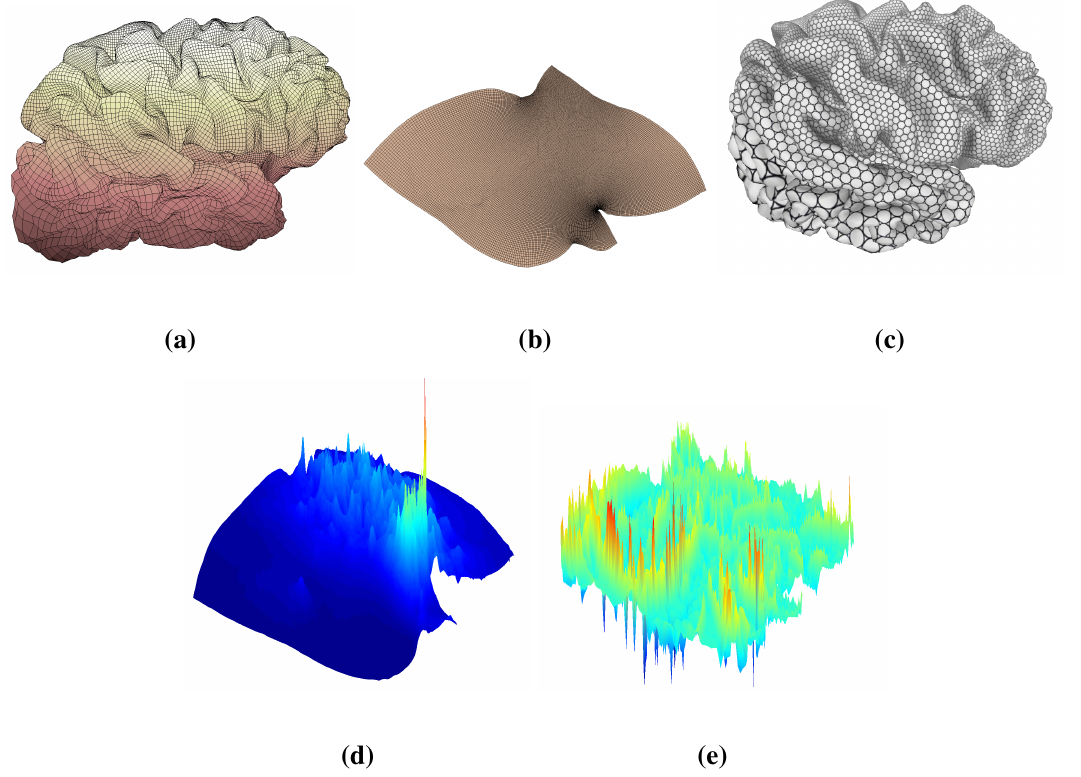
Figure 1. Conformal parameterization of a brain cortical surface. ( a ) The original brain mesh; ( b ) the conformal parameterization onto a rectangular conformal parameter domain in R 2 . We then texture the brain using the parameterization obtained from (b), as shown in ( c ). Note that conformal parameterization maps infinitesimal circles to circles; ( d , e ) the conformal factor of the parameterization and the mean curvature of the brain surface,